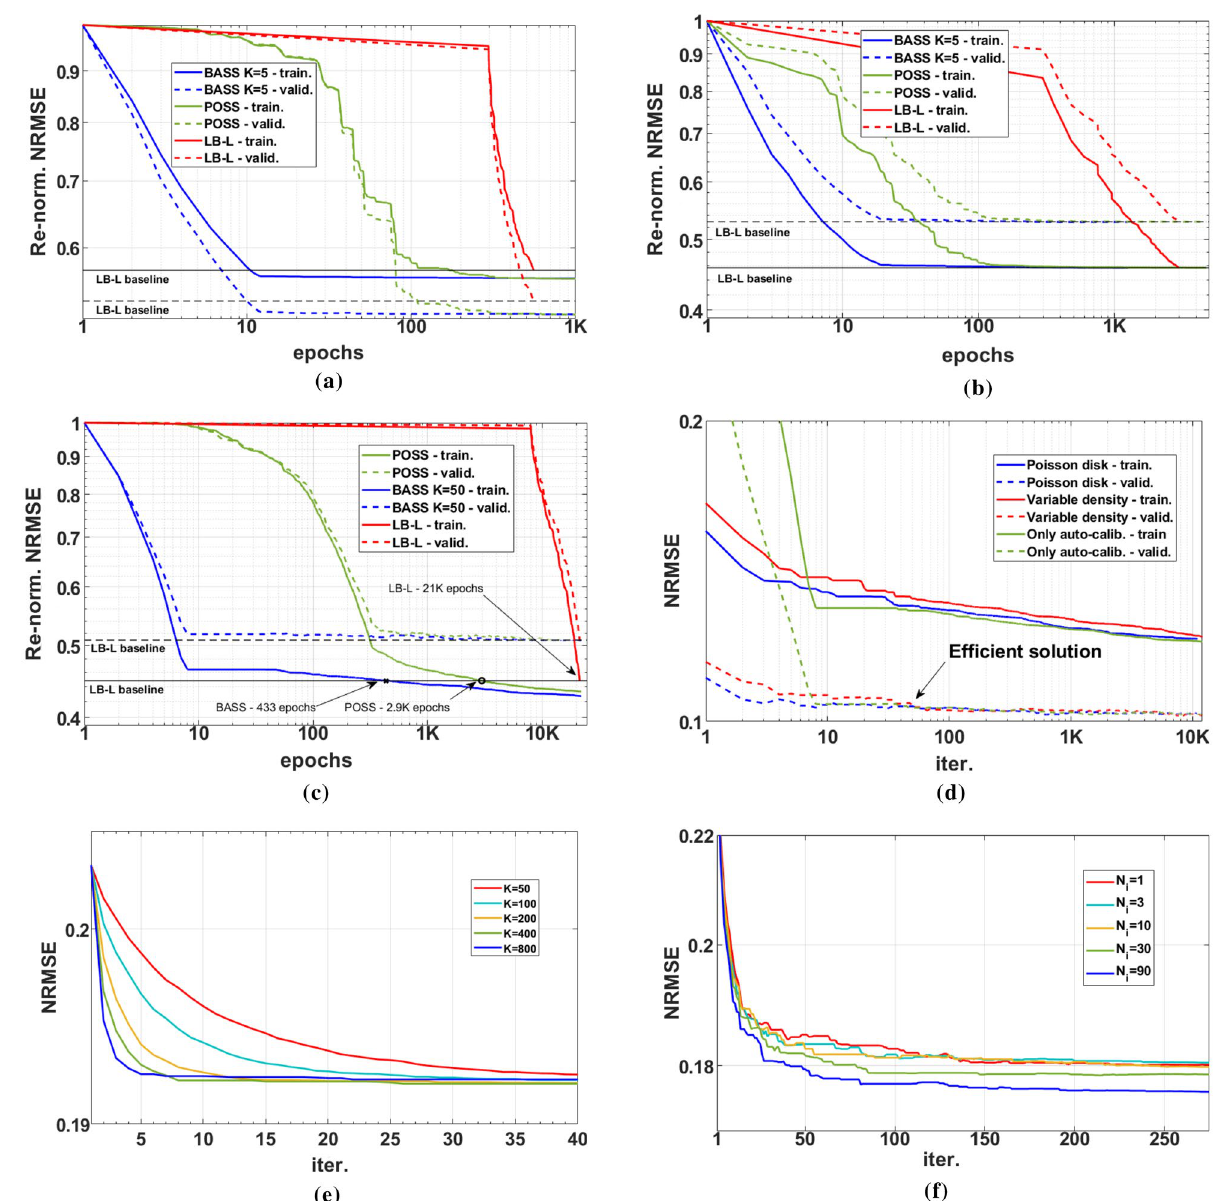
Figure 3. Convergence curves for BASS. Comparison against POSS and the greedy approach LB-L in ( a ) 1D SP using SENSE, ( b ) 1D SP using CS-SFD, and ( c ) 2D SP using CS-SFD. ( d ) Comparing various initial SPs. ( e ) Comparing various K init s. ( f ) Comparing various training